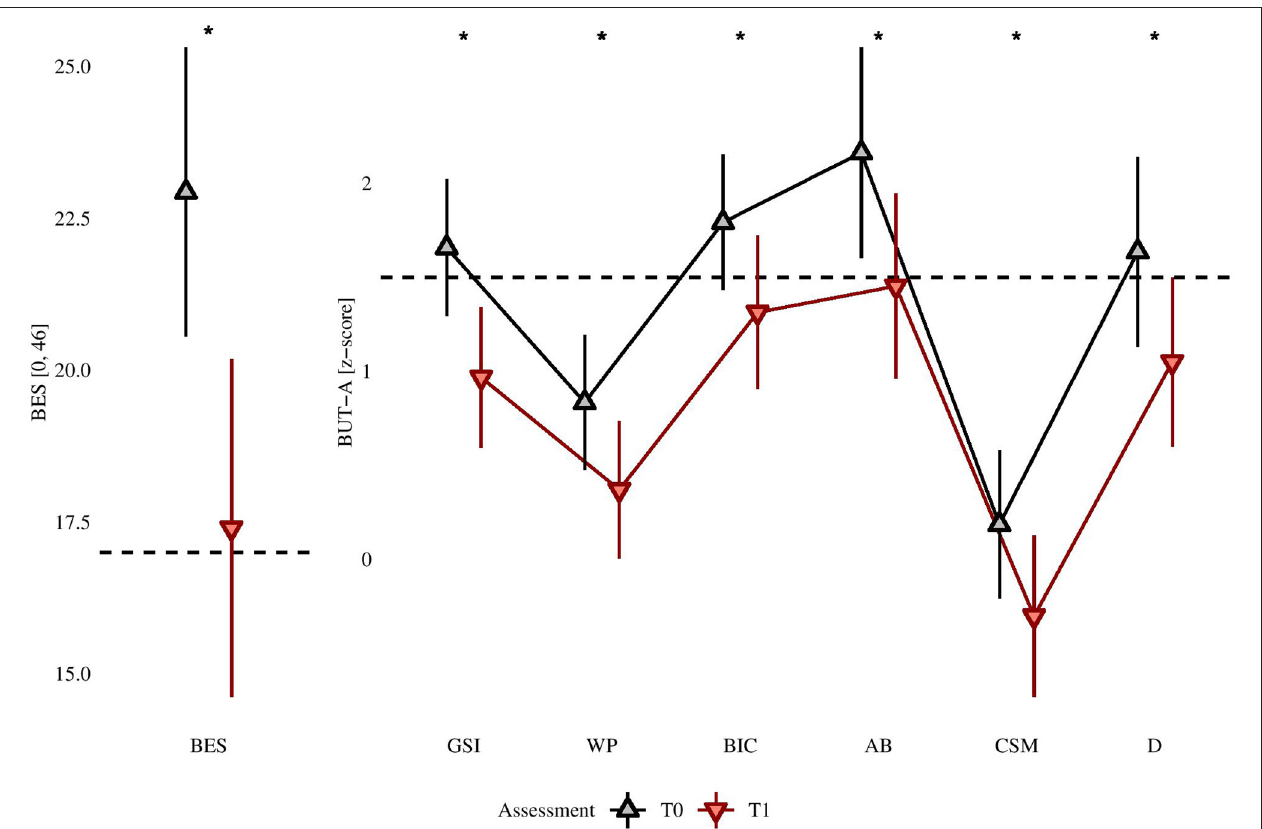
FIGURE 1 | BES raw scores confronted between pre- and post-intervention assessment and BUT-A z- scores. * Post treatment is lower than pre-treatment at statistically significant level, after Benjamini-Hochberg’s correction, with p < 0.050.